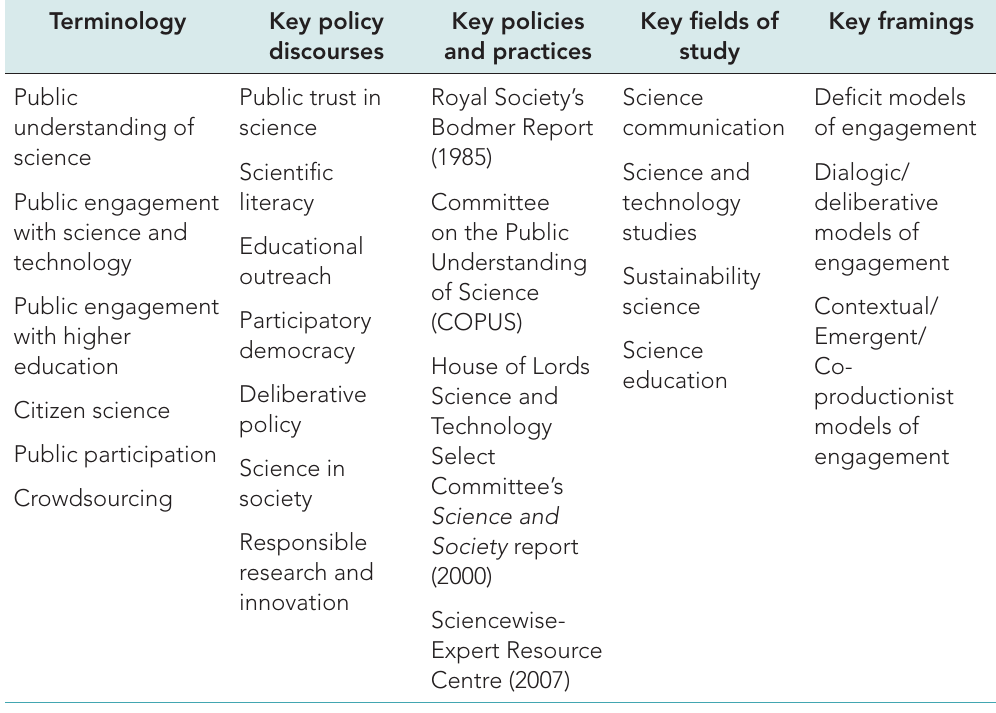
Table 2: Approaches to research engagement within the science and technology